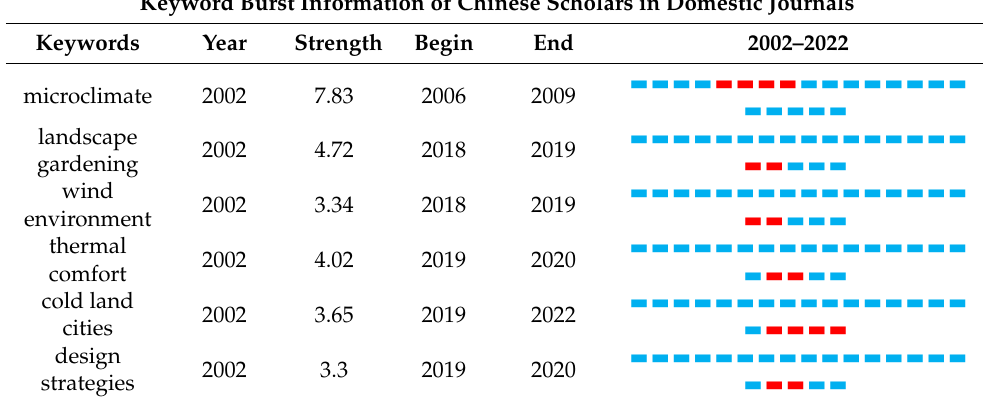
Keyword Burst Information of Chinese Scholars in Domestic Journals